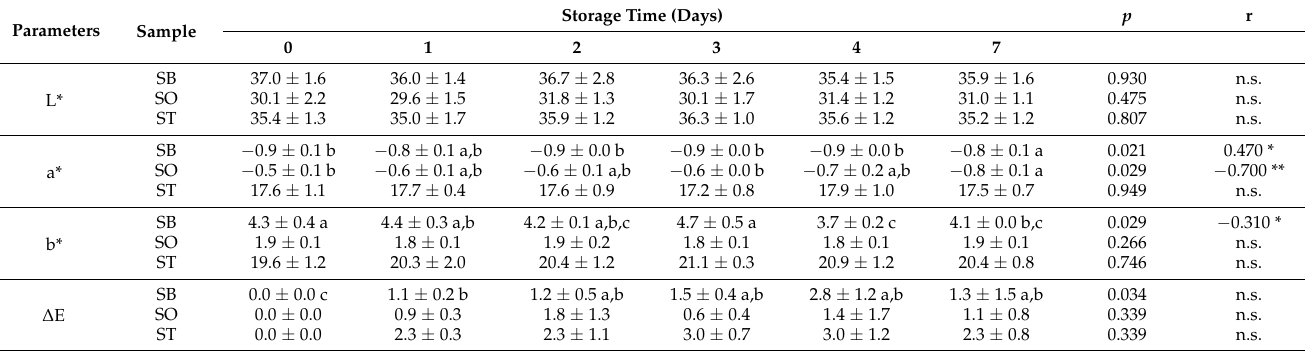
Table 2. Instrumental evaluation of the sauce of canned sardines’ storage at 4 ◦ C (mean ± standard deviation).